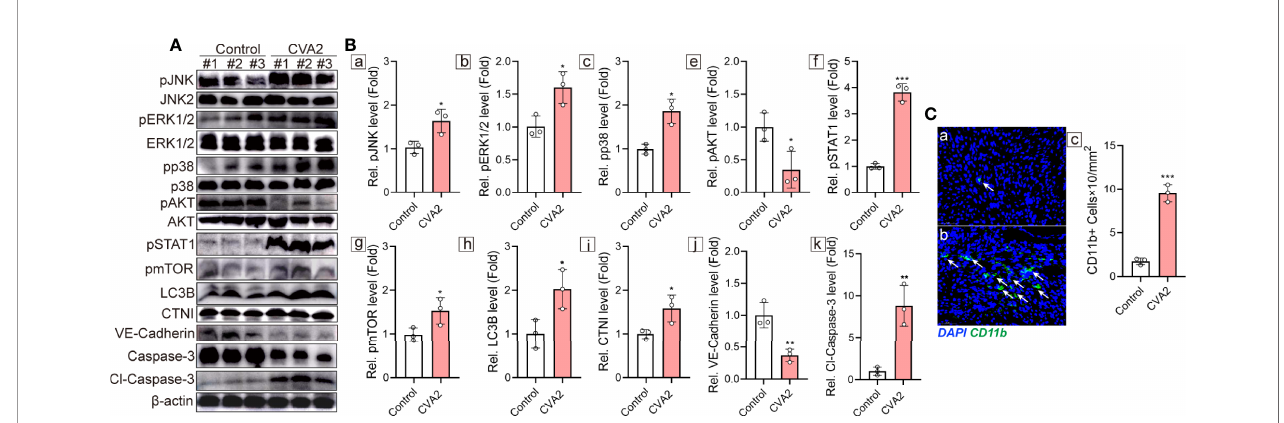
FIGURE 8 | Validation of functional enrichments. At 7 dpi, CVA2-infected mice (n = 3) and controls (n = 3) were euthanized, and heart tissues were taken out for Western blotting (n = 3) and immuno fl uorescence staining (n = 3). (A) Western blotting analyses of pJNK, JNK2, pERK1/2, pp38, p38, pAKT, AKT, pSTAT1, pmTOR, LC3B, CTNI, VE-Cadherin, Caspase-3, Cl-Caspase-3. (B) Relative expression of pJNK (a), pERK1/2 (b), pp38 (c), pAKT (e), pSTAT1 (f), pmTOR (g), LC3B (h), CTNI (i), VE-Cadherin (j), Cl-Caspase-3 (k) were normalized by non-phosphorylated form or actin. (C) CD11b immuno fl uorescence staining of heart slices of